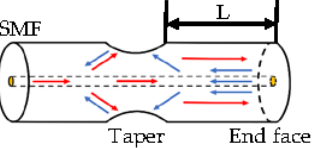
Figure 1. Sketch of the sensor structure and light propagation.